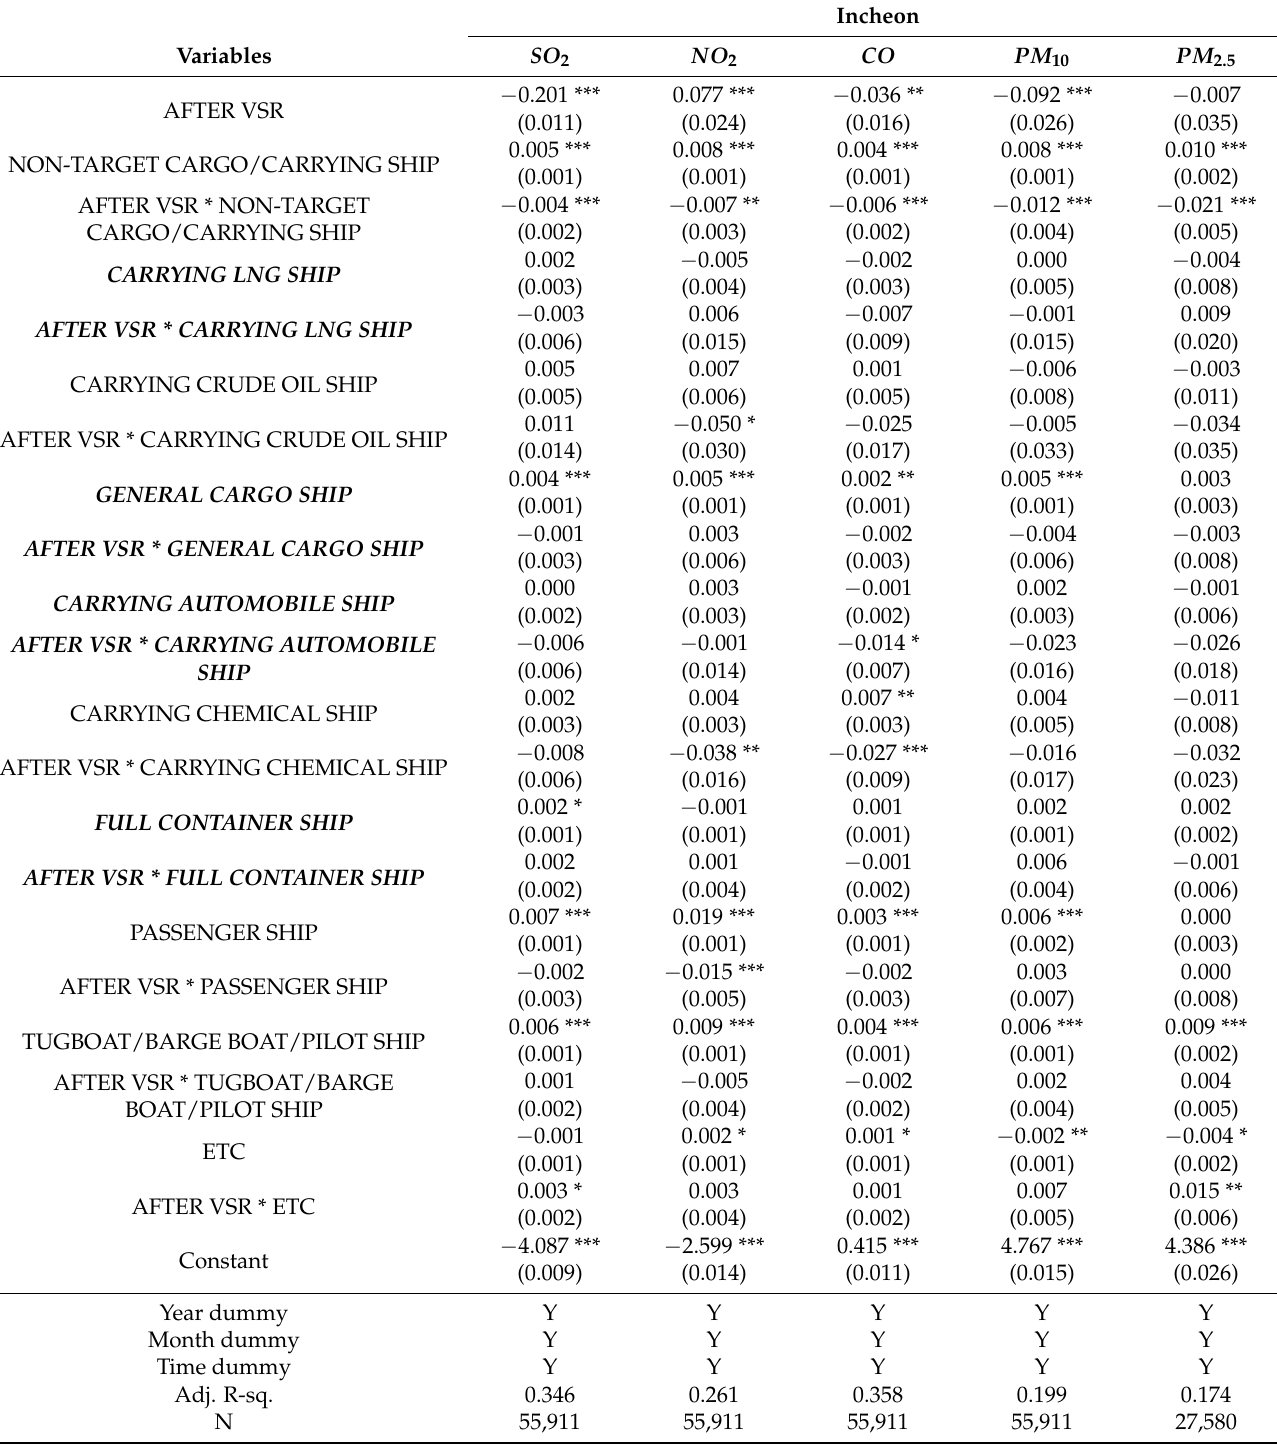
Table 6. Estimation results of Incheon